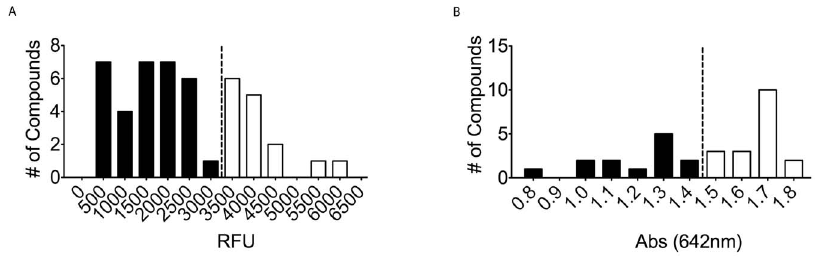
Figure 7. ALPHA-Screen orthogonal assay and RGS4( D 7) counter screen. (A) At 40 m M final for each compound, this assay was used to confirm each compound as an inhibitor of RGS4 (20 nM final) through another assay. The dashed line represents the cutoff, 3 standard deviations from negative control. 15 compounds fell within 3 standard deviations of the negative control and were excluded from further analysis. (B) This single point assay, at 40 m M compound, was used to confirm activity of each compound against the RGS4( D 7) mutant (200 nM final). The dashed line represents 25% inhibition, the cutoff for compounds carried to dose-response analysis. 18 compounds failed to inhibit the RGS4( D 7) mutant of RGS4 and were excluded from further analysis. Filled bars represent compounds carried over to following experiments. Open bars represent compounds excluded from further analysis.